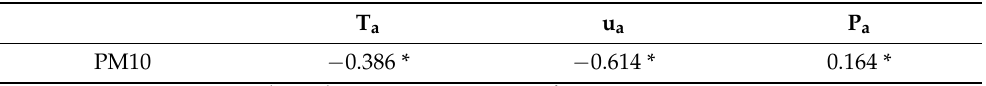
Table 2. Spearman rank correlation coefficients between PM10 and selected meteorological parame- ters in 2018–2021.